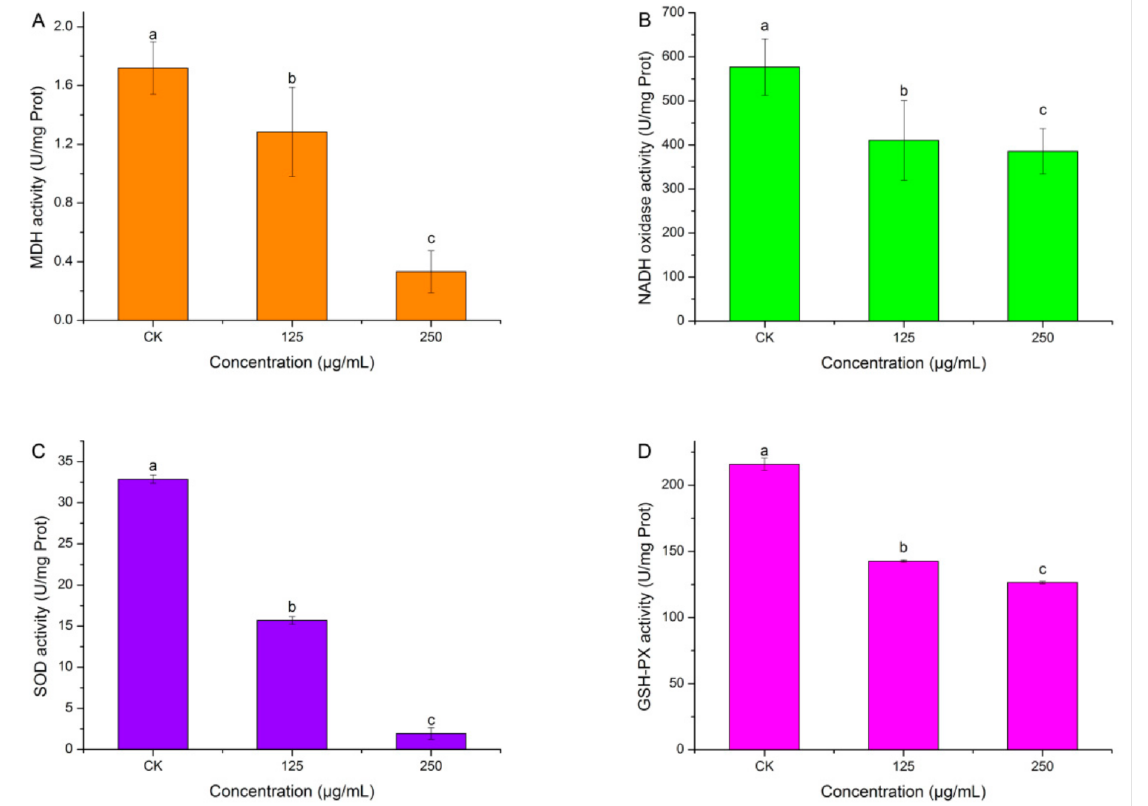
Figure 7. Effect of HBA against respiratory enzymes and antioxidant enzymes activity.